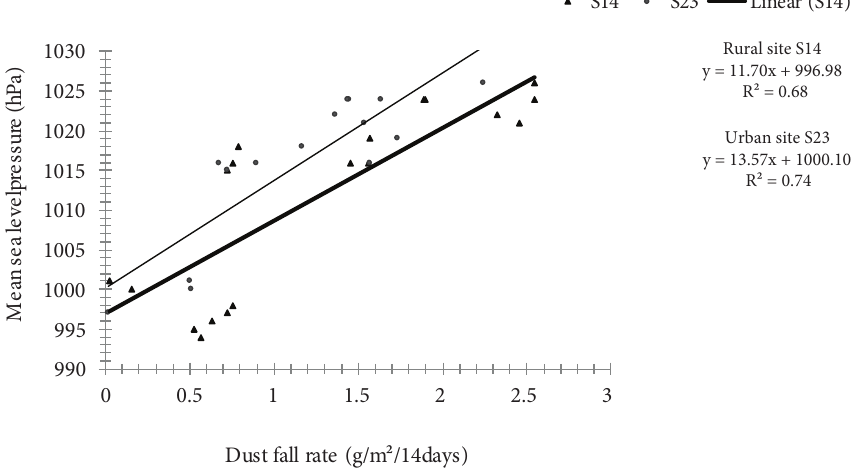
Figure 9. Regressions between mean sea level pressure and biweekly flow deposits trough the two studied sites (S14 and